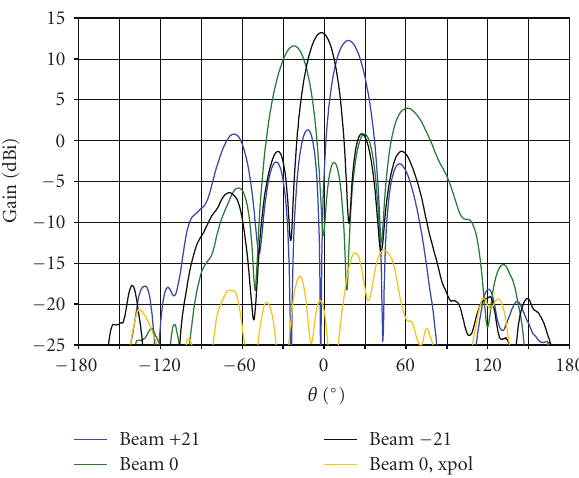
Figure 15: Antenna radiation pattern measurements. Azimuth cut for the three pointing